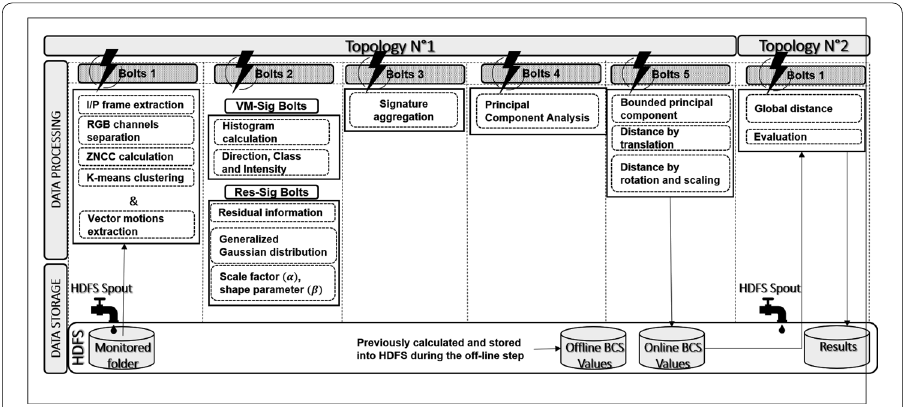
Fig. 9 The proposed CBVR approach using storm real‑time distributed